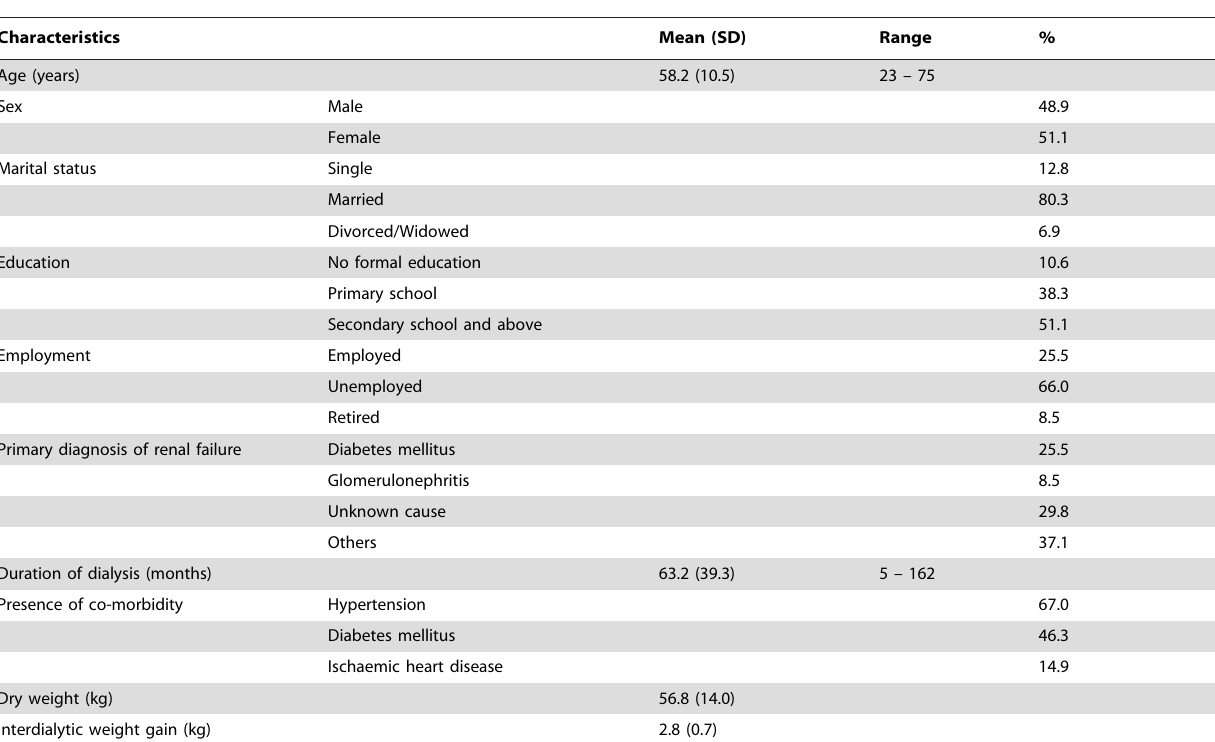
Table 1. Demographics and clinical characteristics of subjects.